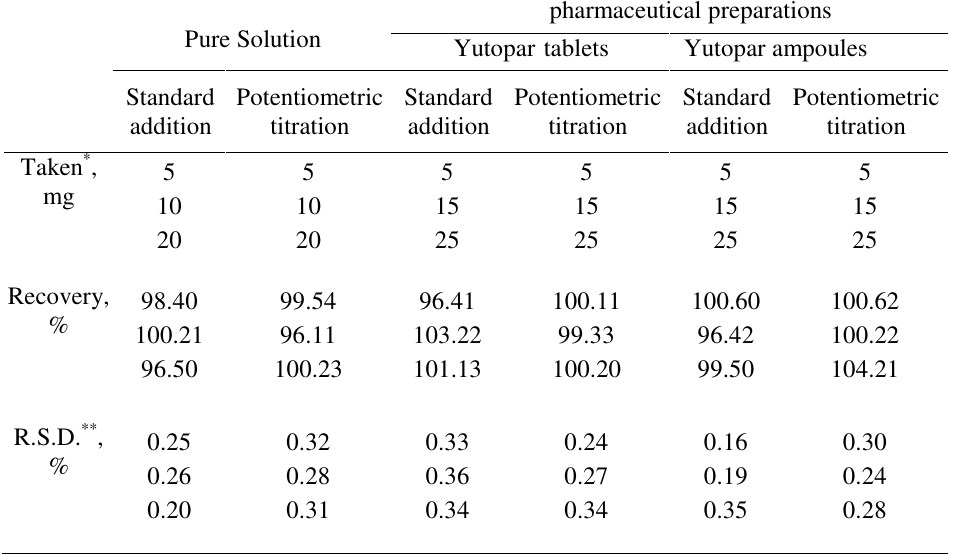
Table 6. Determination of ritodrine HCl in pure form and in pharmaceutical preparations using RTH-selective